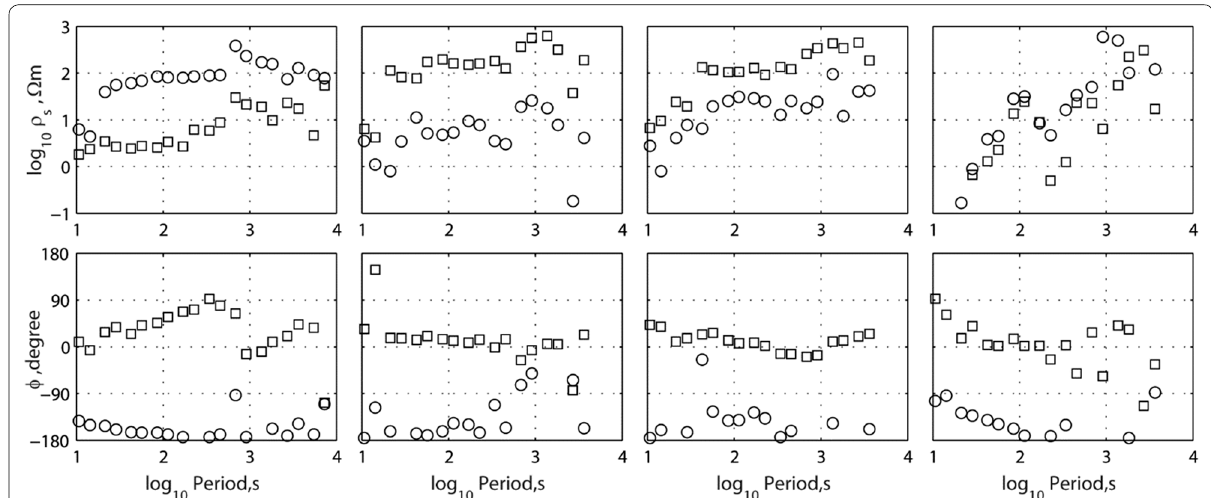
Fig. 9 Marine MT processing results, which are raw data and not pre-filtered by the adaptive canceling filter. From left to right: the resistivity and phases of site SH-R8, SH-R10, SH-R11, and SH-R13 are shown. The xy components are represented by squares, and the yx components are represented by circles